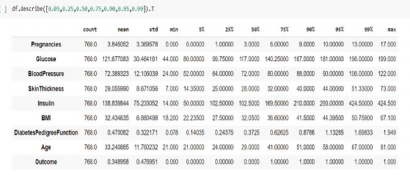
Figure 1: Description of